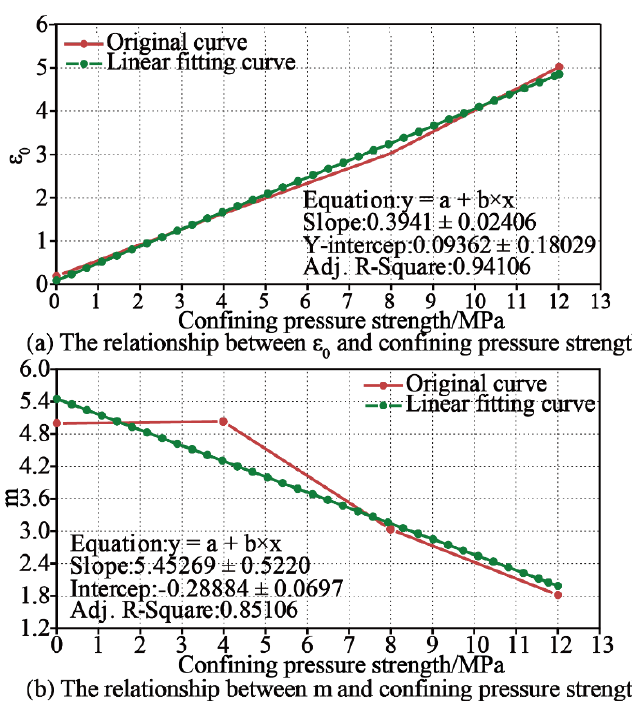
Figure 14. The relations between unknown parameters and confining pressure strength.